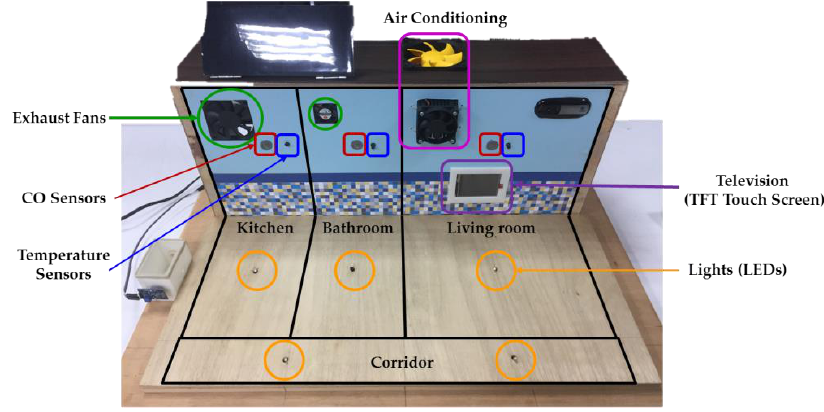
Figure 4. Experimental testbed of the smart home.